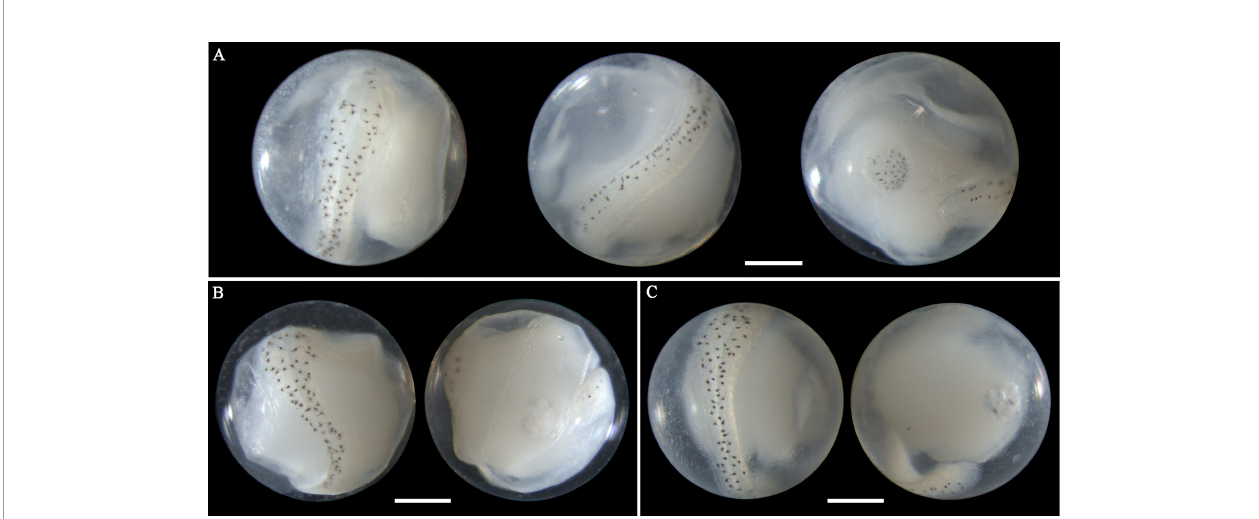
FIGURE 4 | Images of ethanol- fi xed eggs of Sillago sihama in (A) late stage with single pigmented oil globule, (B) late stage with single less-pigmented oil globule, and (C) middle stage with single less-pigmented oil globule. Images within each panel represent the same egg photographed from different observation views. Scale bar for images =200 m m.